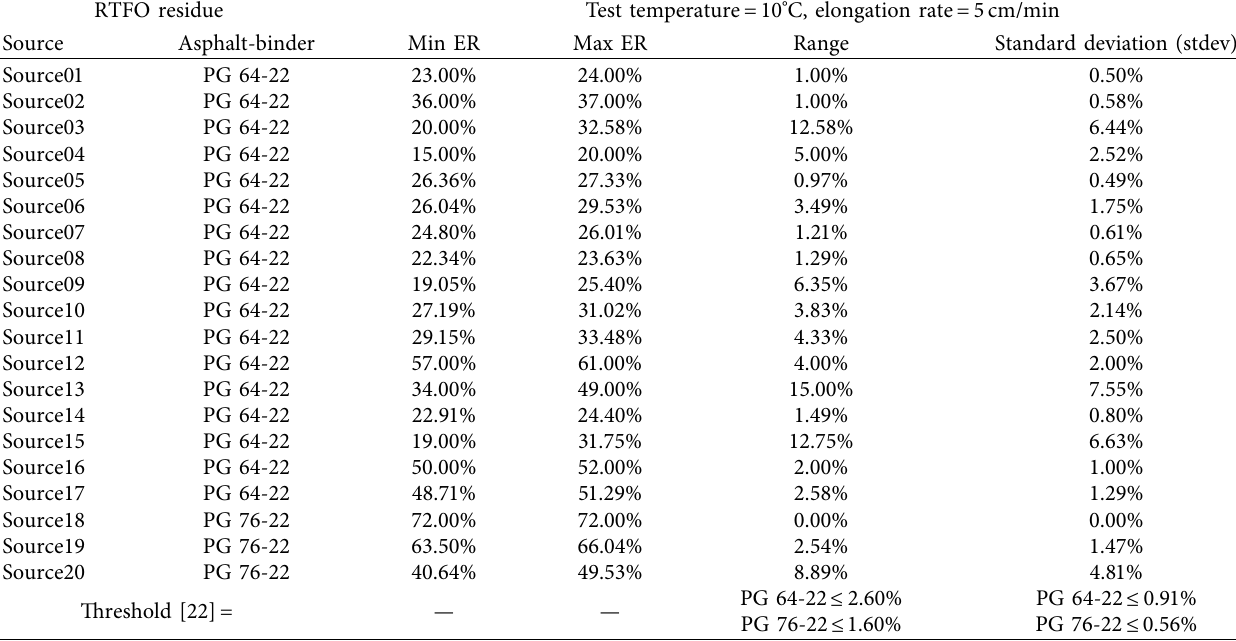
Table 3: ER range and standard